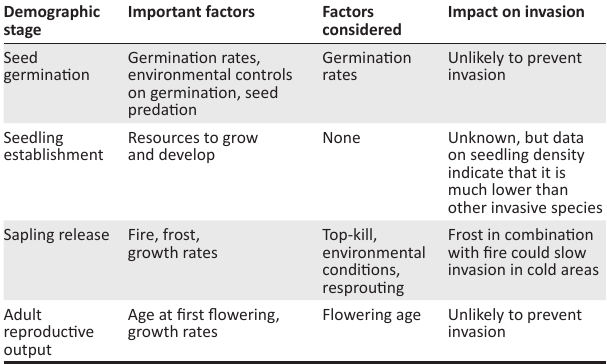
TABLE 3: Summary of results in relation to demographic stage – and which factors might be important but were not considered in this